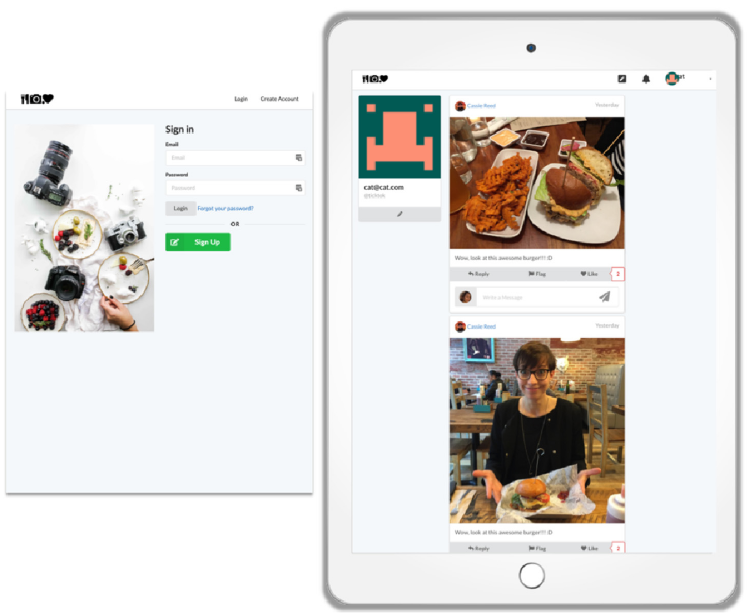
Fig 1. The social network site EatSnap.Love (left: Sign in page; right: Example of how the platform and the feed looks like to the user). The amount of posts in which the users disclosed themselves (an example is the lower post in the feed) was manipulated. In study 1, either 0%, 20% or 80% of the posts show the face of the user, and either 0%, 20% or 80% of the profile pictures showed the user. In Study 2, either 5% or 80% of the posts showed the user. n = 576 ( M = 36.9 years ( SD = 11.6, range = 19–87; 59.4% female; 4% bachelor or college